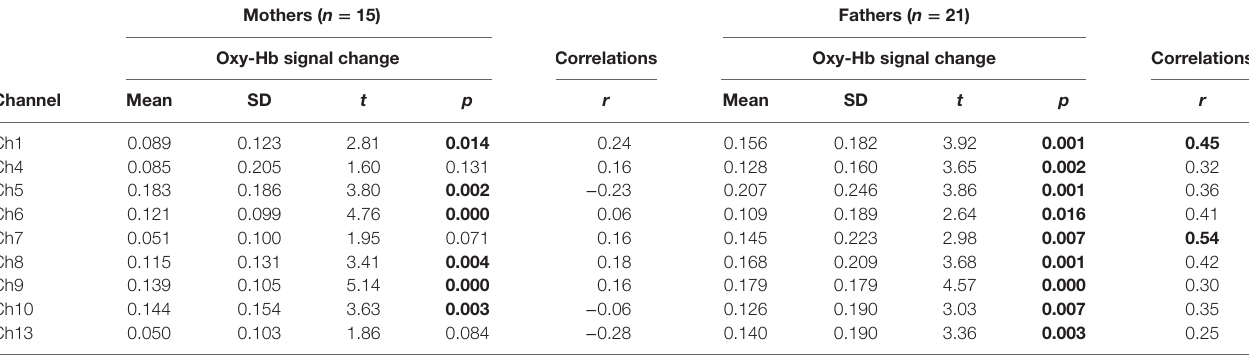
Table 4 | Functional data summary and correlations between oxy-Hb signal change and salivary OT levels for ROI channels among mothers and fathers,